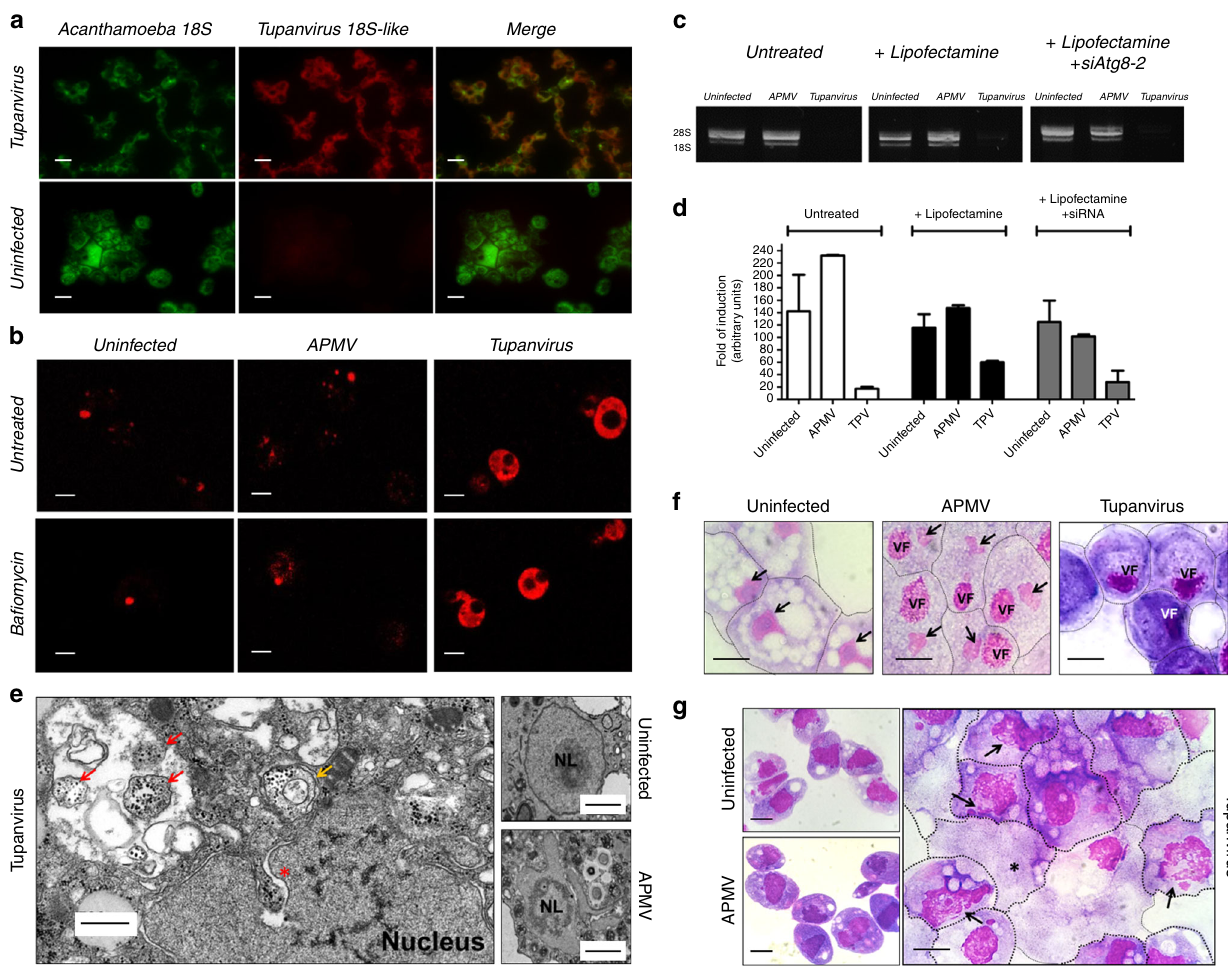
Fig. 7 Tupanvirus soda lake biological features in a host ( A. castellanii ) and non-host ( Tetrahymena sp.). a Expression of Tupanvirus 18S intronic sequence- copy 1 transcript, 12 h post-infection observed by fl uorescence in situ hybridization (FISH) (red). Tupanvirus-induced shutdown of A. castellanii ribosomal RNA18S transcripts (green). Scale bars, 10 µ m. b Tupanvirus, but not mimivirus, induces strong acidi fi cation of A. castellanii cytoplasm (9 h.p.i.), even in the presence of ba fi lomycin A1. Scale bars, 10 µ m. c , d The silencing of the canonical autophagy protein Atg8-2 does not prevent rRNA shutdown induced by Tupanvirus infection. Error bars, standard deviation. e Electron microscopy of A. castellanii infected by Tupanvirus (2 h.p.i.), highlighting the degradation of the nucleolus, nuclear disorganization and the formation of ribosome-containing vesicles near nuclear membranes. Scale bar, 500 nm. Red arrow: single- membrane vesicles containing ribosomes; orange arrow: double-membraned vesicles containing ribosomes; asterisk: ribosomes wrapping by the external nuclear membrane. Right: electron microscopy of uninfected amoebae and APMV infected cell (8 h.p.i.) showing a mild nucleolar disorganization in the presence of the virus. Scale bars: 1 µ m. f Haemacolour staining showing the nuclear degradation of A . castellanii induced by Tupanvirus infection (9 h.p.i.) compared with infection by mimivirus (APMV) and uninfected cells. Tupanvirus-infected cells are purplish because of cytoplasm acidi fi cation. Scale bars, 5 µ m. Arrows: nucleus, when present; VF: viral factory. g Haemacolour staining showing the nuclear degradation in Tetrahymena sp . induced by Tupanvirus infection (4 days post-inoculation) compared with mimivirus (APMV)-inoculated cells and uninfected cells. Tupanvirus-infected cells present an atypical shape and intense vacuolization, and some cells lack a nucleus (asterisk). Arrows: nucleus under degradation. Scale bars, 5 µ m. The experiments were performed 3 times independently, with two replicates